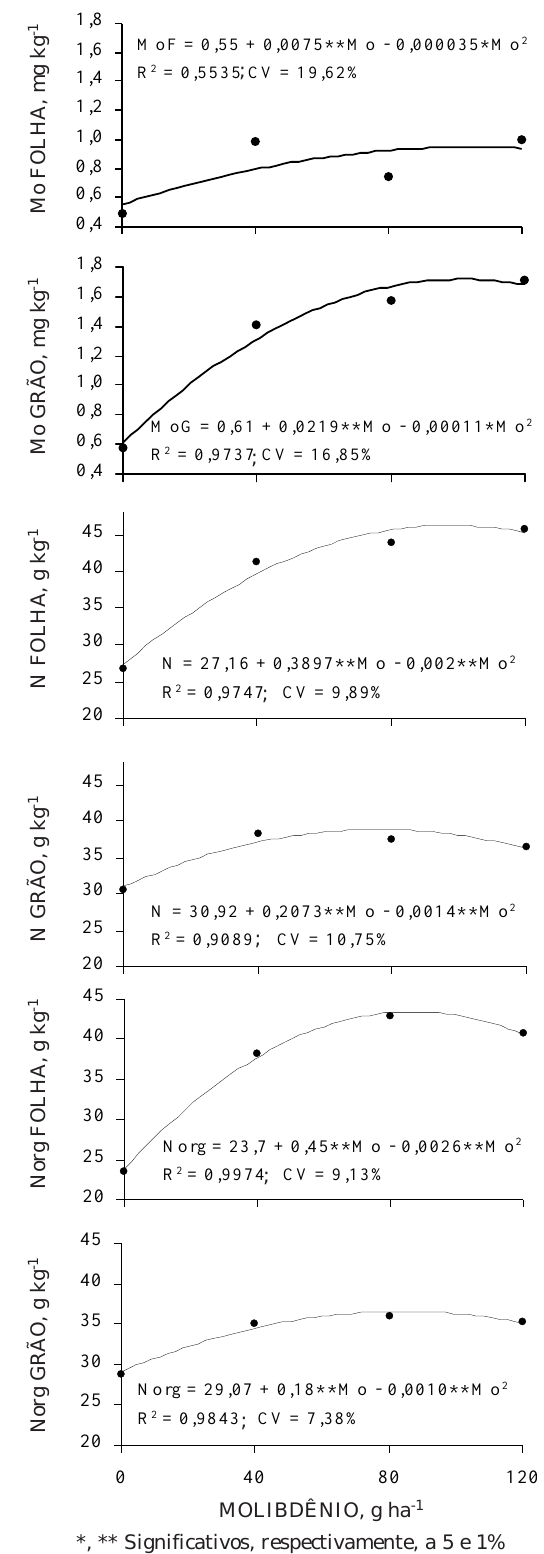
Figura 1. Produtividade de grãos do feijoeiro cv. Ouro Negro, cultivado na safra outono-inverno de 1996, em função da adubação foliar com molibdênio.